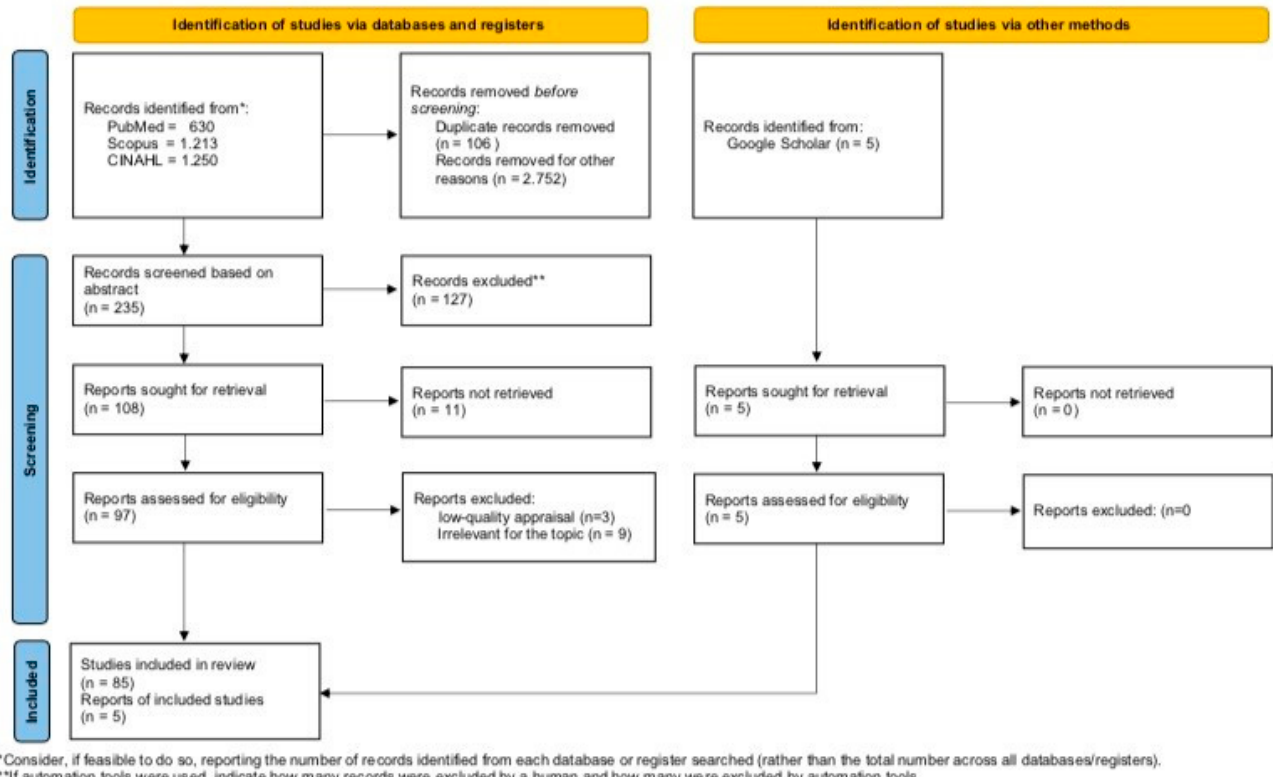
Figure 1. PRISMA 2020 flow diagram for new systematic reviews, including searches of databases, registers, and other sources.